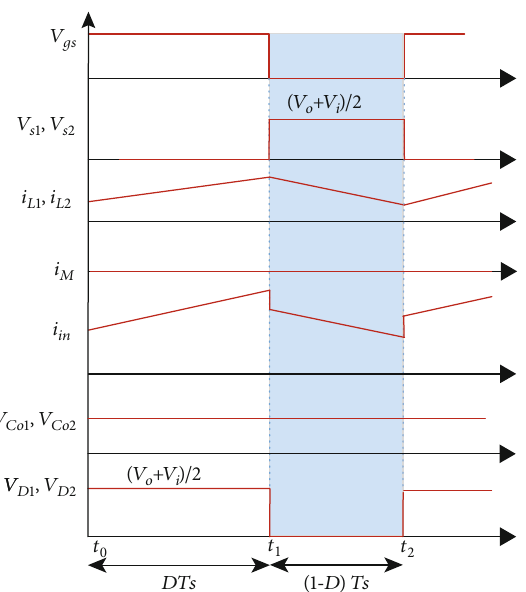
Figure 3: Key waveform in CCM